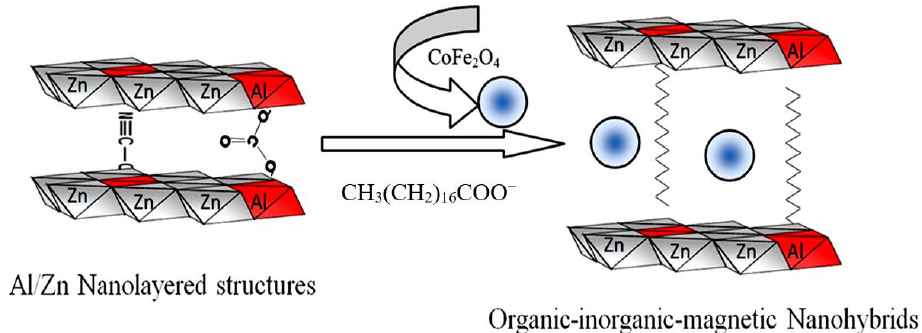
Figure 1. Schematic representation for building organic-inorganic-magnetic nanohybrids.